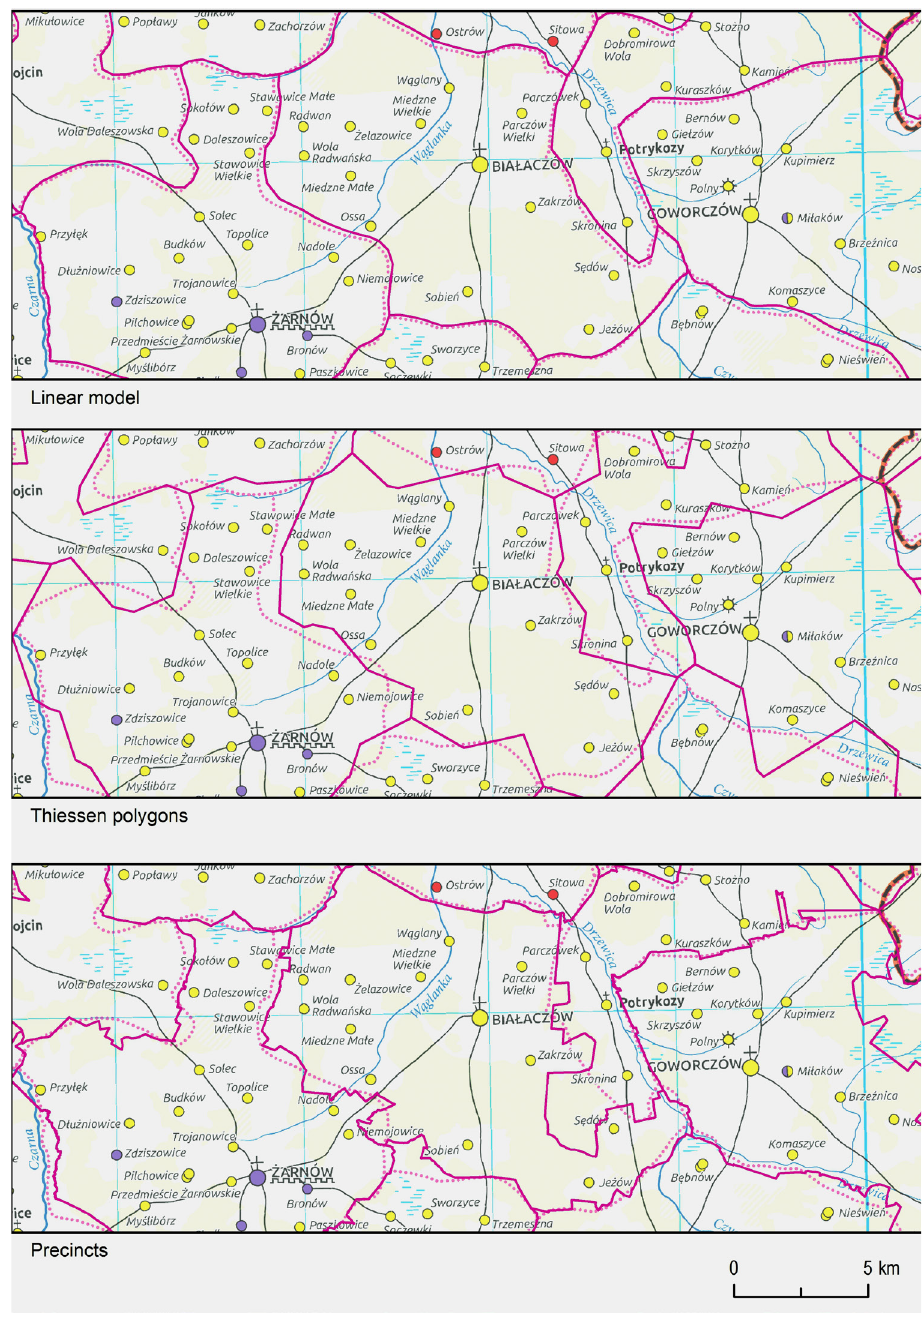
Fig. 3. A part of the HAP main map with parish boundaries developed using three methods: the linear model, Thiessen polygons, and attribution of precincts; the base map is an English edition of HAP, and the dotted line represents the linear